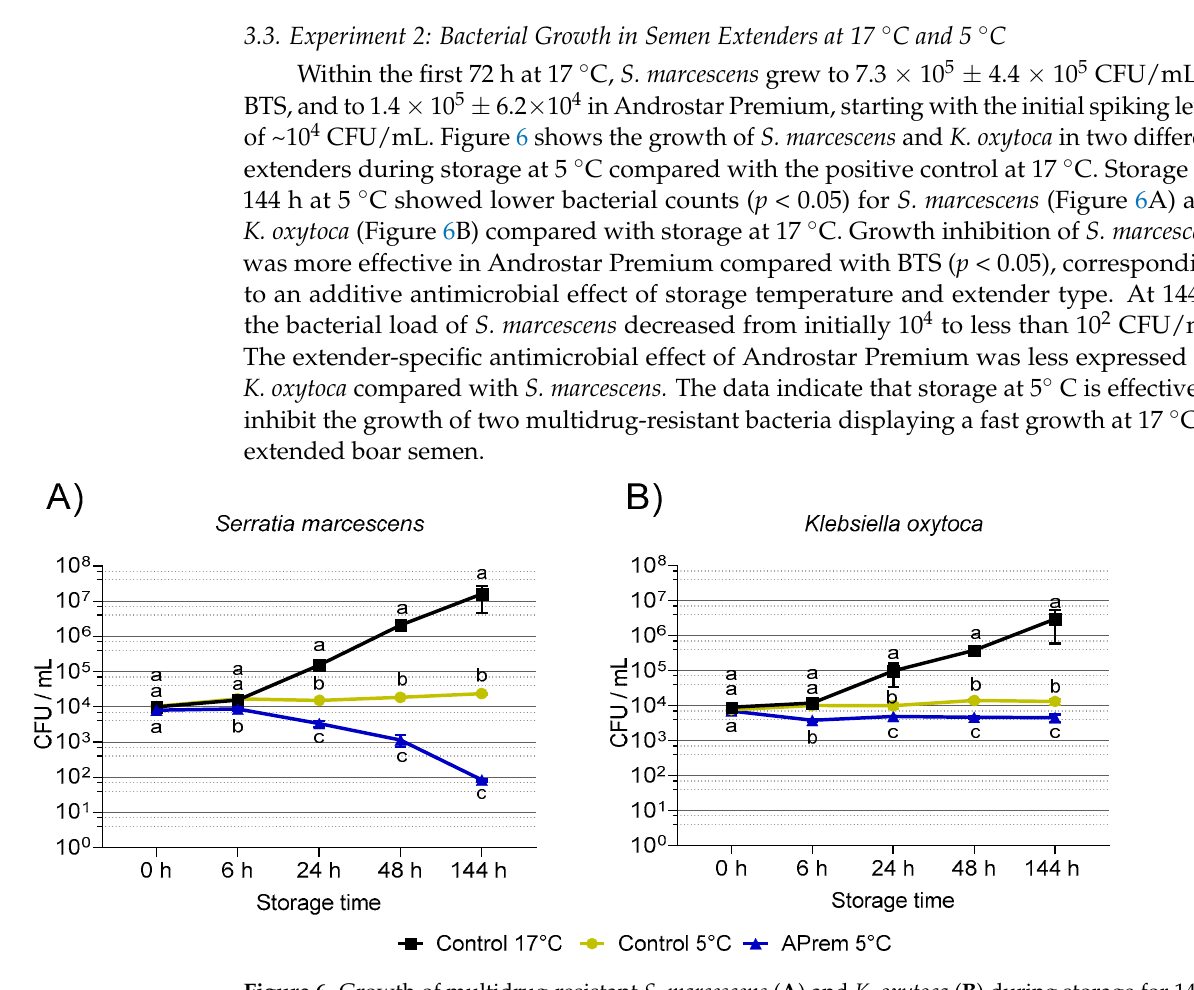
Figure 6. Growth of multidrug-resistant S. marcescens ( A ) and K. oxytoca ( B ) during storage for 144 h at 5 ◦ C in BTS and Androstar Premium extender. Samples stored in BTS at 17 ◦ C were used as controls. a–c: Different lowercase letters indicate differences between semen extenders at a given storage time point ( p <